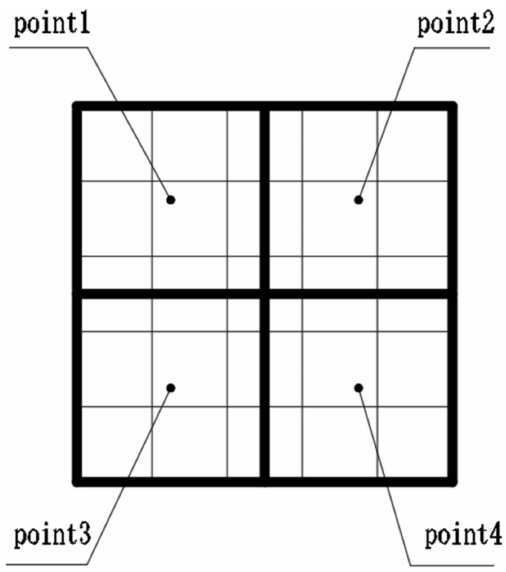
Figure 4. Wind speed measuring points on air